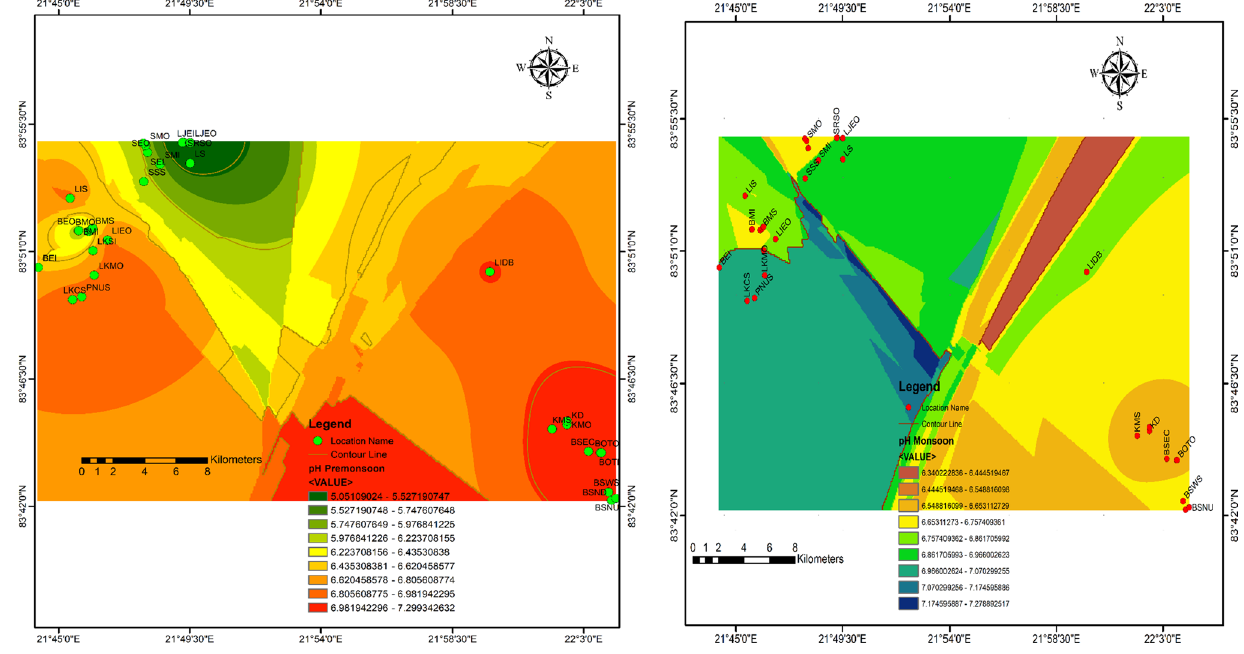
Fig. 10 Contour map of pH in water samples during premonsoon and monsoon